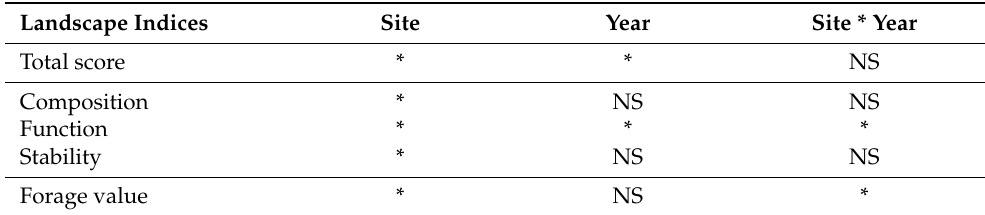
Table 6. Statistical significance of F ratios from the analysis of variance for indices of landscape composition, function, and stability, and forage value index.